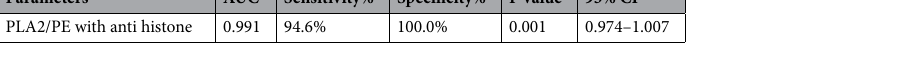
Table 6. Combined ROC